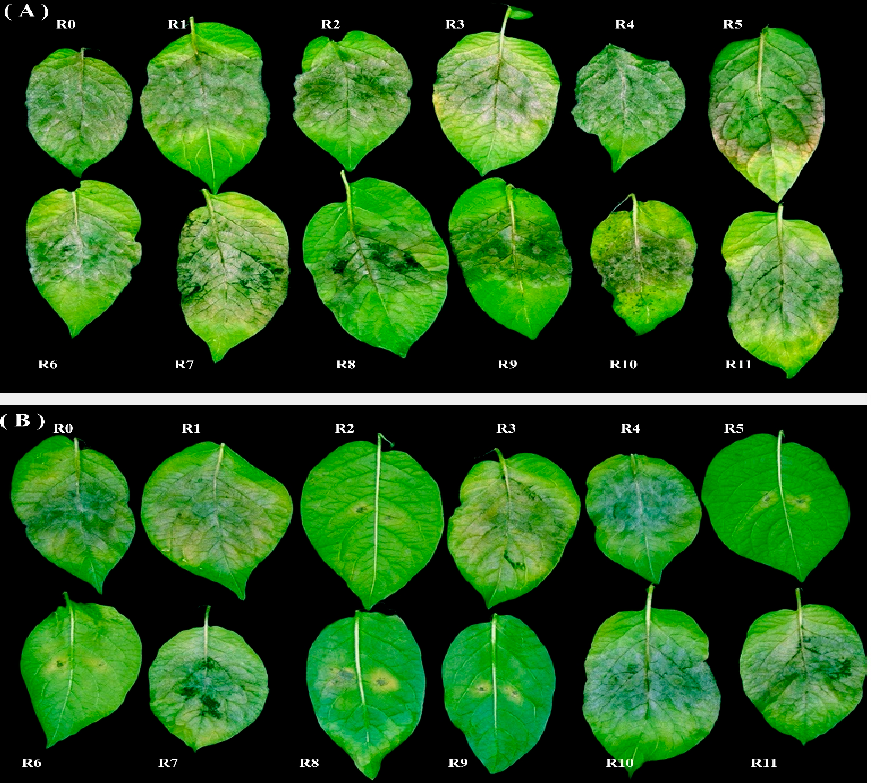
Figure 3. Detached-leaflet assay of two different isolates of P. infestans, ( A ) EG-96 and ( B ) EG-75, on 11 differential sets of potato clones carrying R1 to R11, and Craig’s Royal (R0) as a positive control.